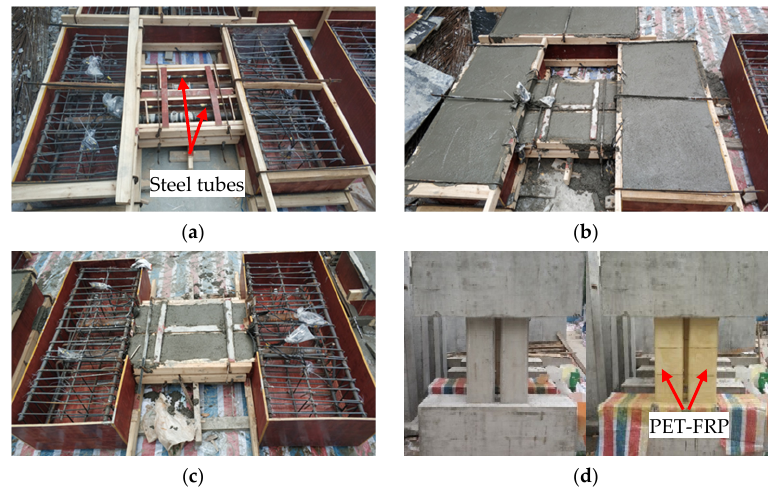
Figure 2. Specimen manufacture: ( a ) steel tubes and formwork; ( b ) integral cast in place; ( c ) prefabrication of coupling beam; ( d ) polyethylene terephthalate fiber-reinforced polymer (PET-FRP) strengthening.